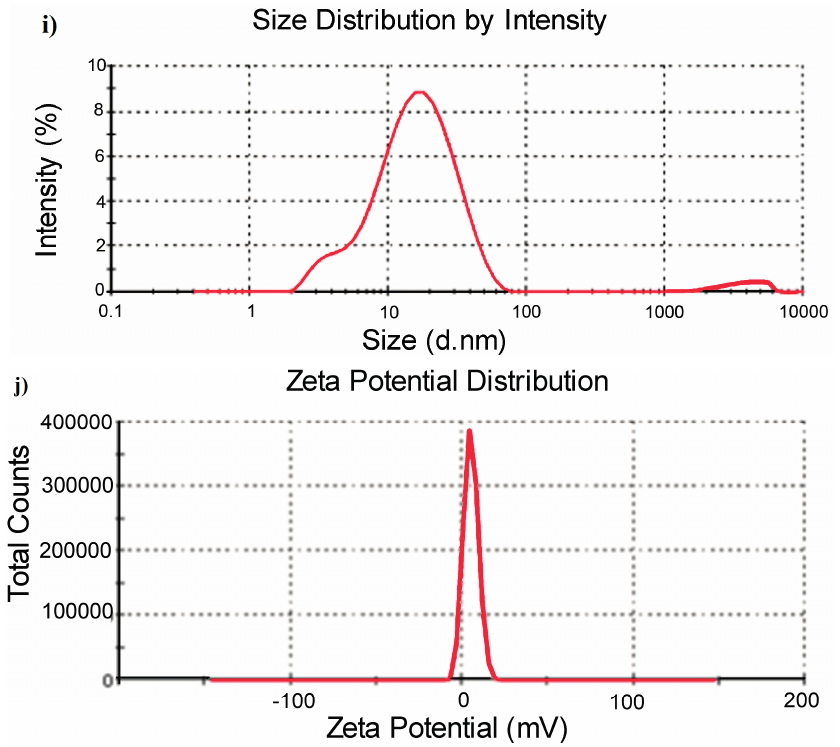
Figure 1. ( a ) Transmission electron microscopy (TEM) and ( b ) high-resolution (HR)-TEM images of CdTe QDs; ( c ) size distribution analysis of CdTe quantum dots (QDs); ( d ) TEM and ( e ) HR-TEM of dendrimer modified CdTe/CdS QDs; ( f ) size distribution analysis of dendrimer modified CdTe/CdS QDs; ( g ) X-ray powder diffraction (XRD) diffraction patterns of CdTe QDs and dendrimer modified CdTe/CdS QDs; ( h ) Selected area electron diffraction (SAED) pattern of dendrimer modified CdTe/CdS QDs; ( i ) zeta potential and ( j ) hydro diameter distribution of freshly prepared QDs.